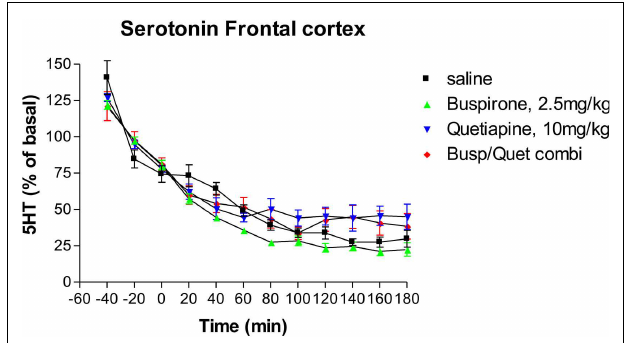
FIGURE 1 |The effect of Buspirone (2.5mg/kg i.p.) alone ( n = 7), Quetiapine (10mg/kg i.p.) alone ( n = 7), the combination of these two drugs (Busp/Quetcombi; n = 7), and saline vehicle control (saline; n = 9) on extracellular levels ofof serotonin in rat frontal cortex. Drugs were administered at time zero, values are means ± SEM.There were no statistically significant differences between any of the four groups.